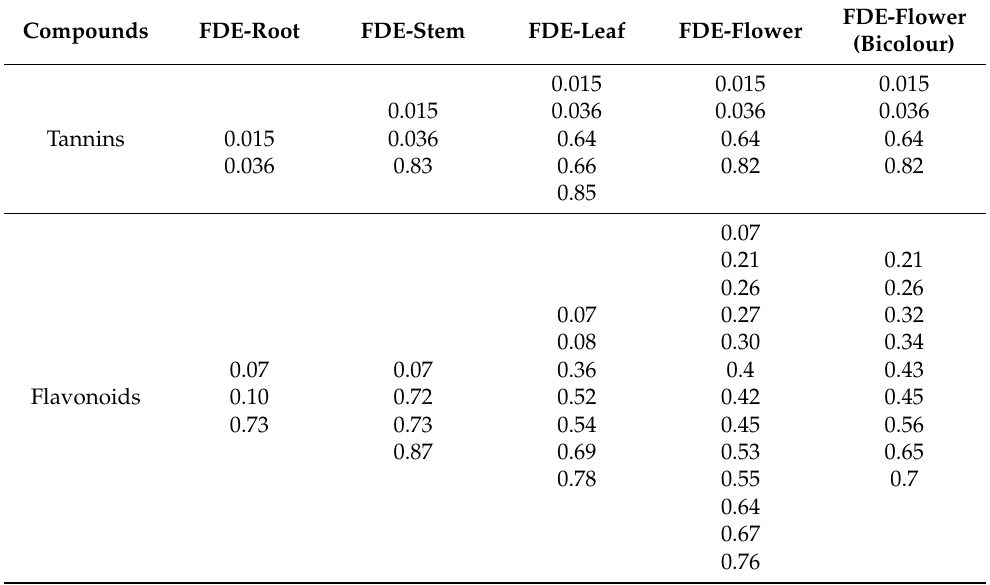
Table 2. Retention factors (R.F.) revealed FDEs for tannins and flavonoids. Compounds FDE-Root FDE-Stem FDE-Leaf FDE-Flower